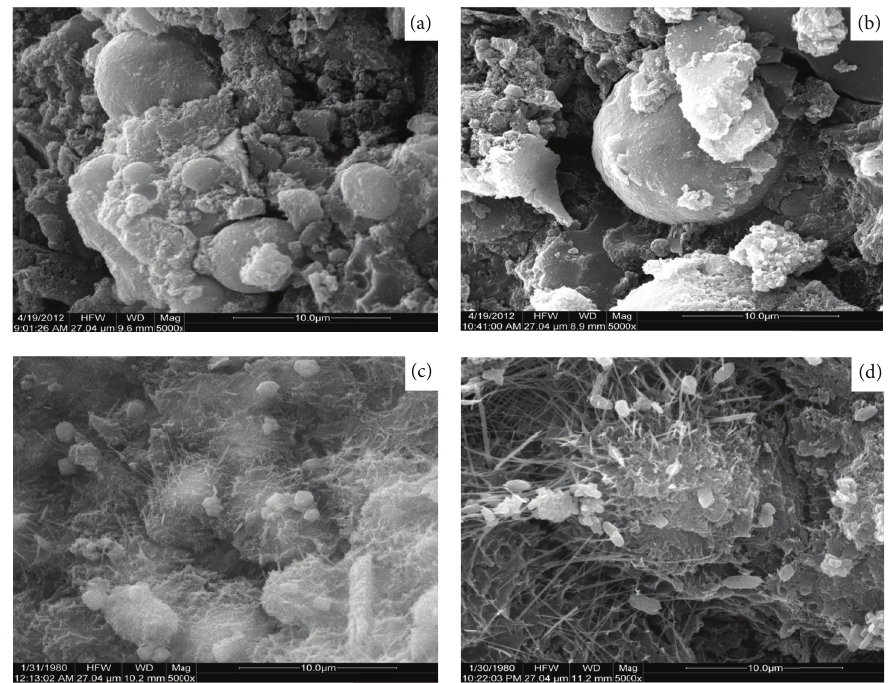
Figure 13: Microstructure of hydration products of ((a) and (b)) R6 and G6 at 28 days and ((c) and (d)) R6 and G6 at 90